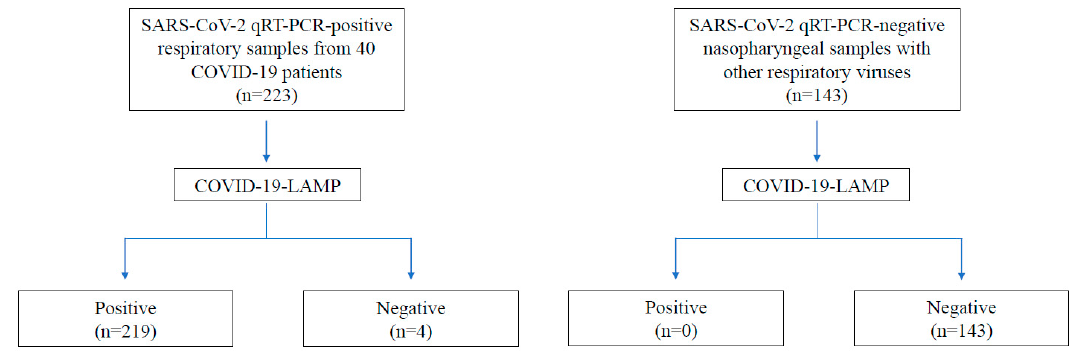
Figure 3. COVID-19-LAMP evaluation profile. SARS-CoV-2 qRT-PCR positive and negative respiratory samples are used for evaluation of COVID-19-LAMP.